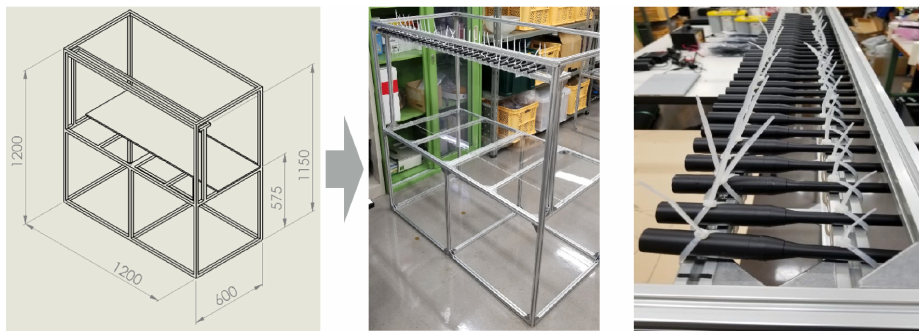
Figure 4. Originally designed and assembled sensor mount.